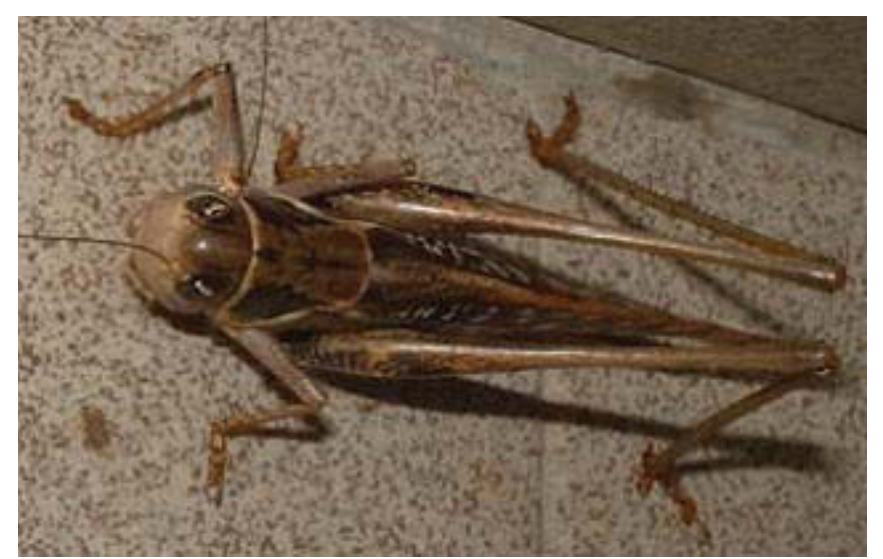
Figure 3. A photo of a grasshopper taken in Raiano at the beginning of August